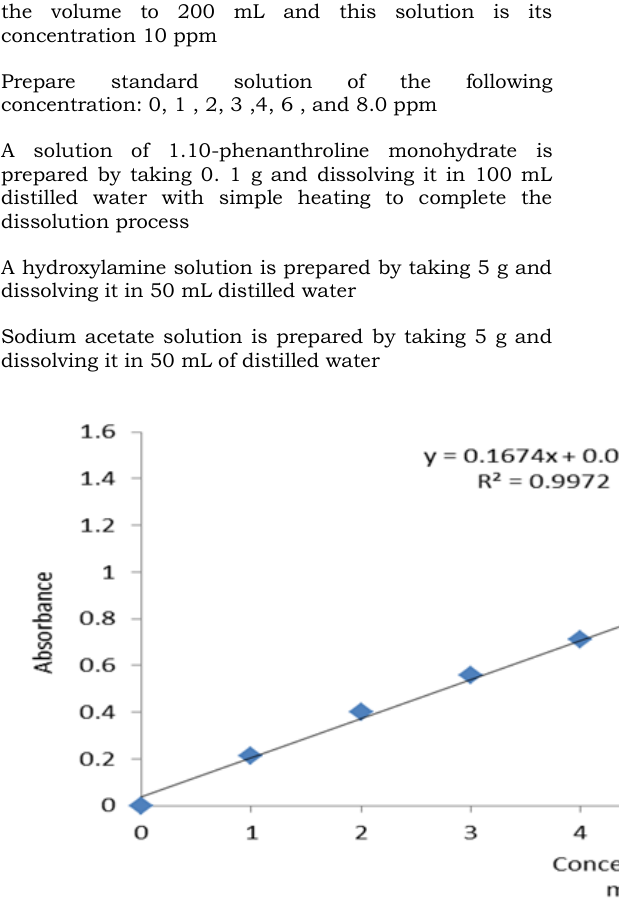
Fig. 1. Diagram of the calibration curve between the absorbance and concentration of the